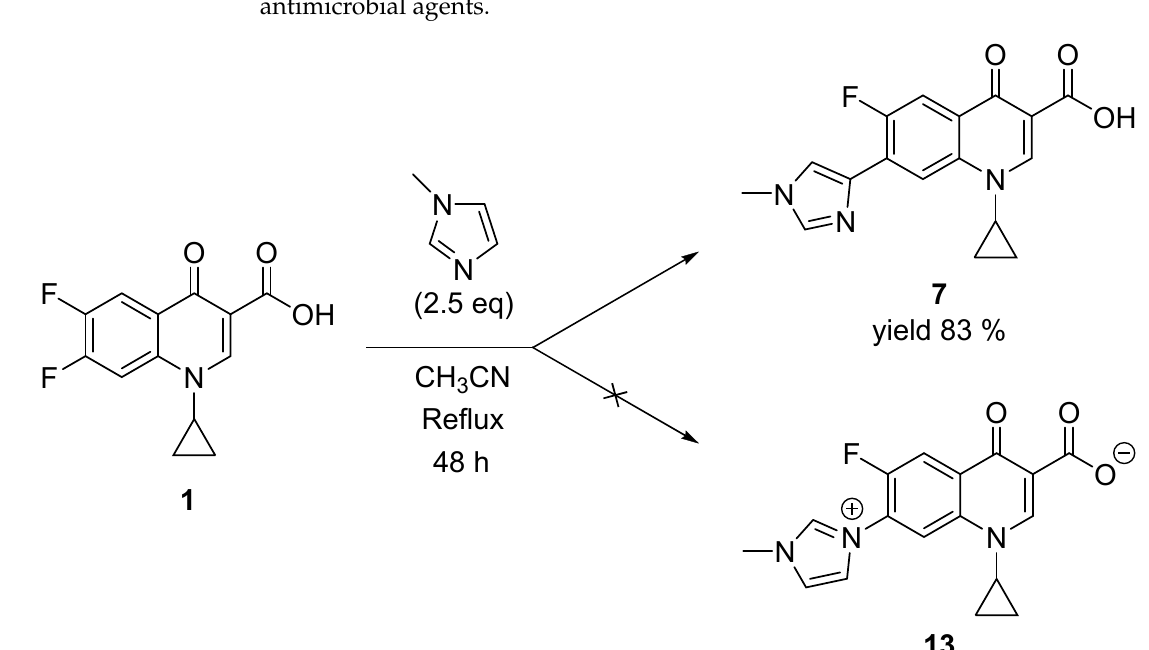
Figure 4. Obtention of 7 as the only product of the reaction between 1 and 1 ‐ methylimidazole .